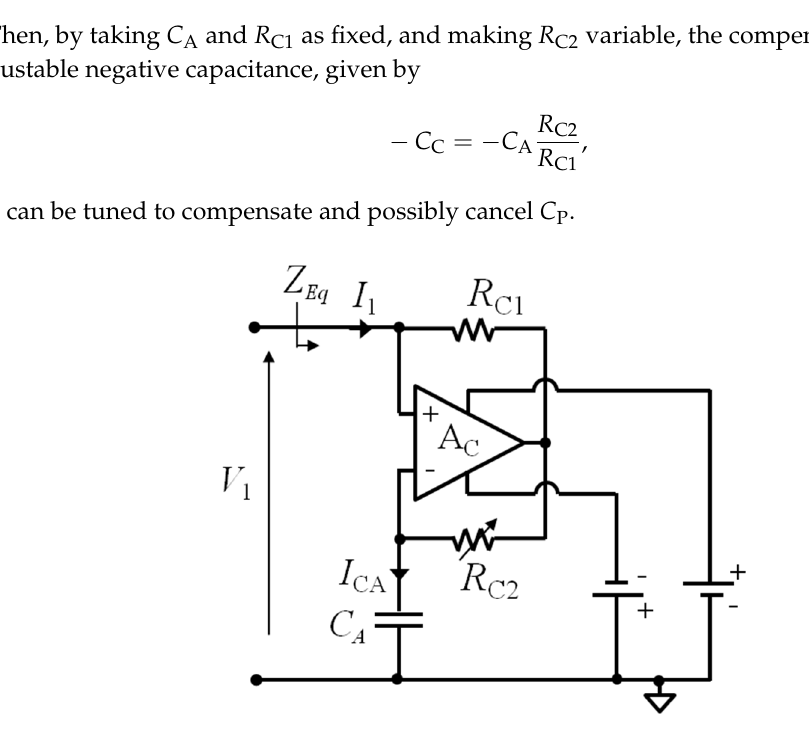
Figure 16. Schematic diagram of the parasitic capacitance compensation circuit.